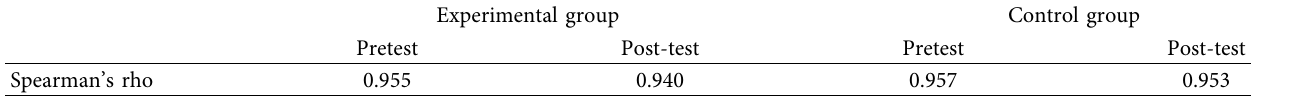
Table 1: Summary of interrater reliability.